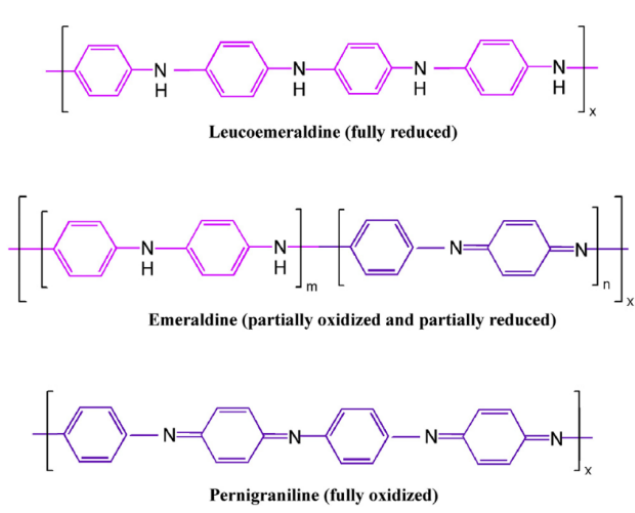
Figure 6. Polyaniline structures with different B/Q ratios.